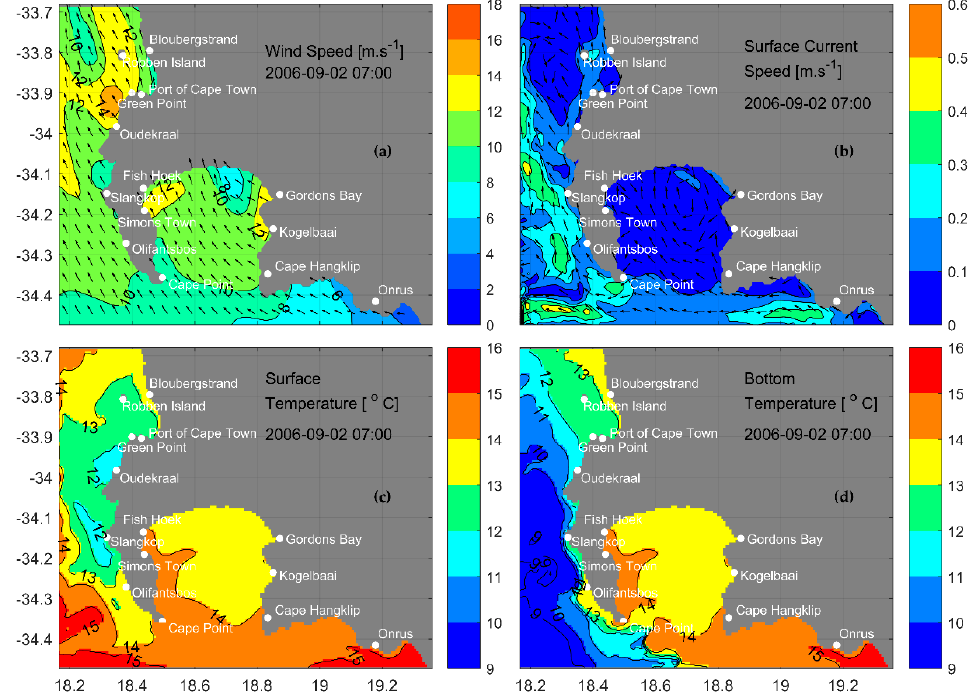
Figure 15. Strong south-easterly winds ( a ), surface currents ( b ), surface temperatures ( c ) and bottom temperatures ( d ). The onset of upwelling along the western Cape Peninsula in response to the winds is evident.